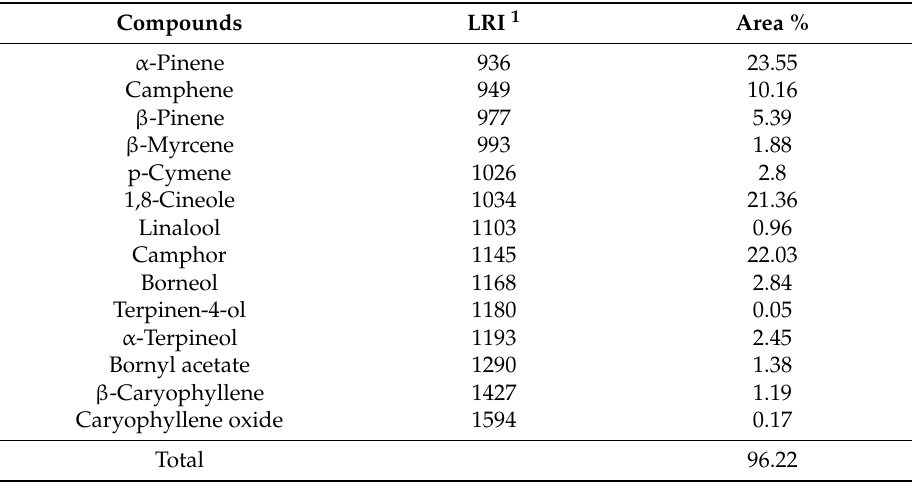
Table 2. Composition of the essential oil of Rosmarinus officinalis